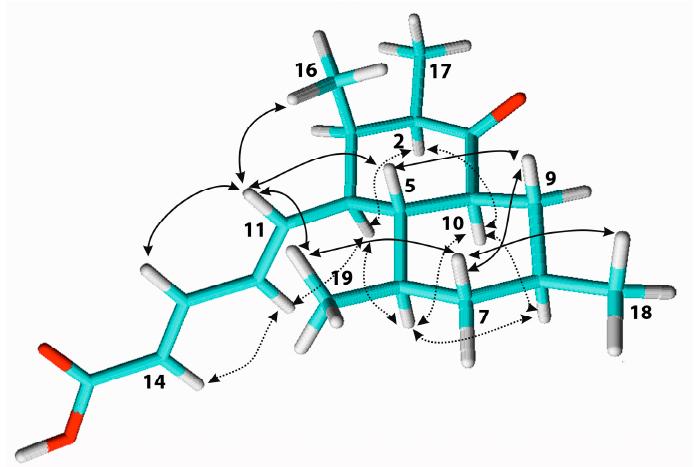
Figure 2. Selected correlation spectroscopy (COSY)/total correlated spectroscopy (TOCSY) (bold lines) and heteronuclear multiple bond (HMBC) (arrows) correlations indicative for the planar structure of elsinopirin A ( 1 ).